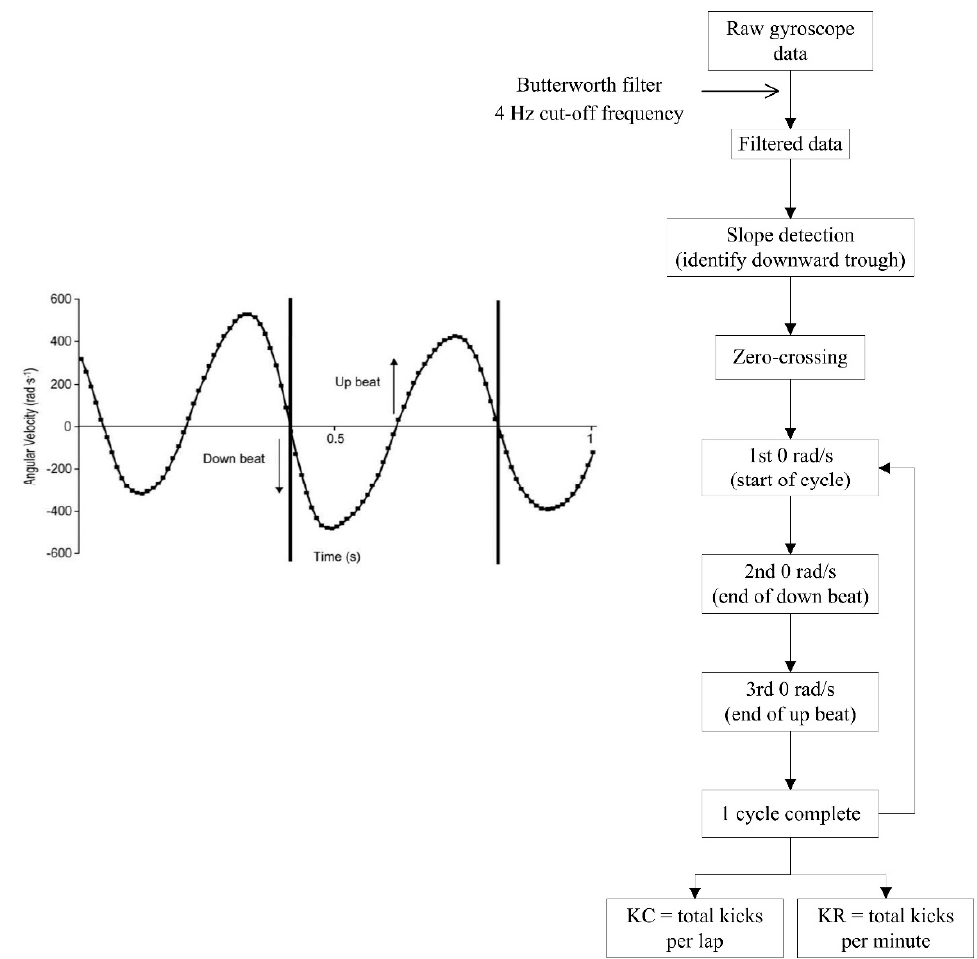
Figure 20. Process flowchart for detecting kick count and kick rate from angular velocity signals. Reproduced with permissions from Fulton, Pyne and Burkett [33].